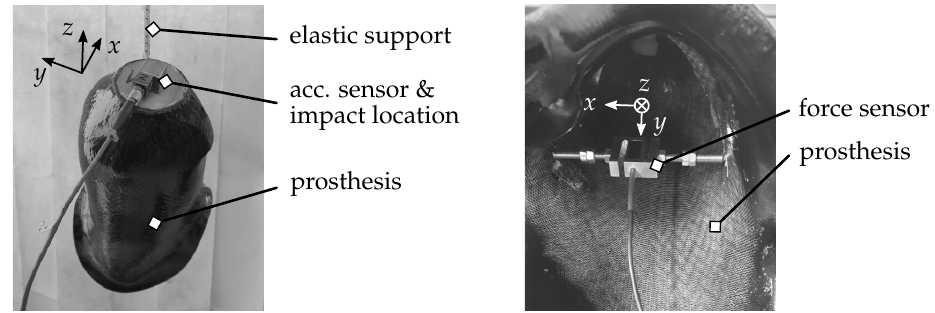
Figure 3. Test setup for experimental analysis of the prosthesis socket. ( left ) Outer view of the test setup showing prosthesis, elastic support and location of excitation and response of the system. ( right ) Inner view showing the position of the force